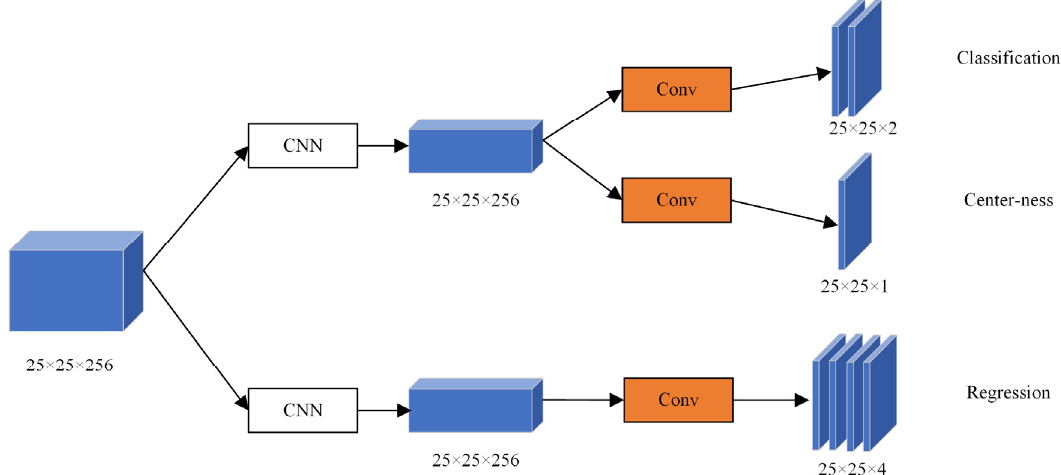
Figure 6. Classi fi cation and Regression Network. Figure 6. Classification and Regression